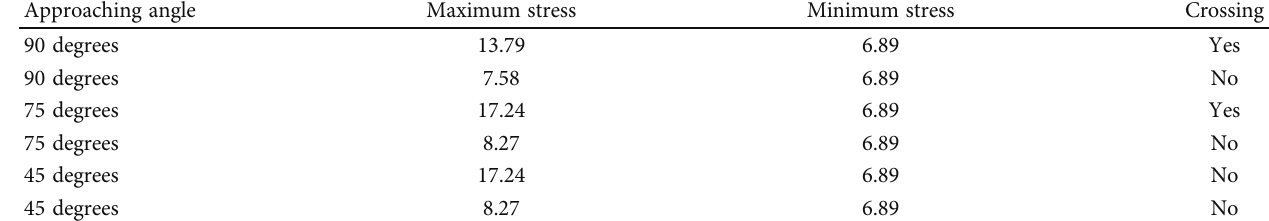
Table 2: Key parameters for veri fi cation model.